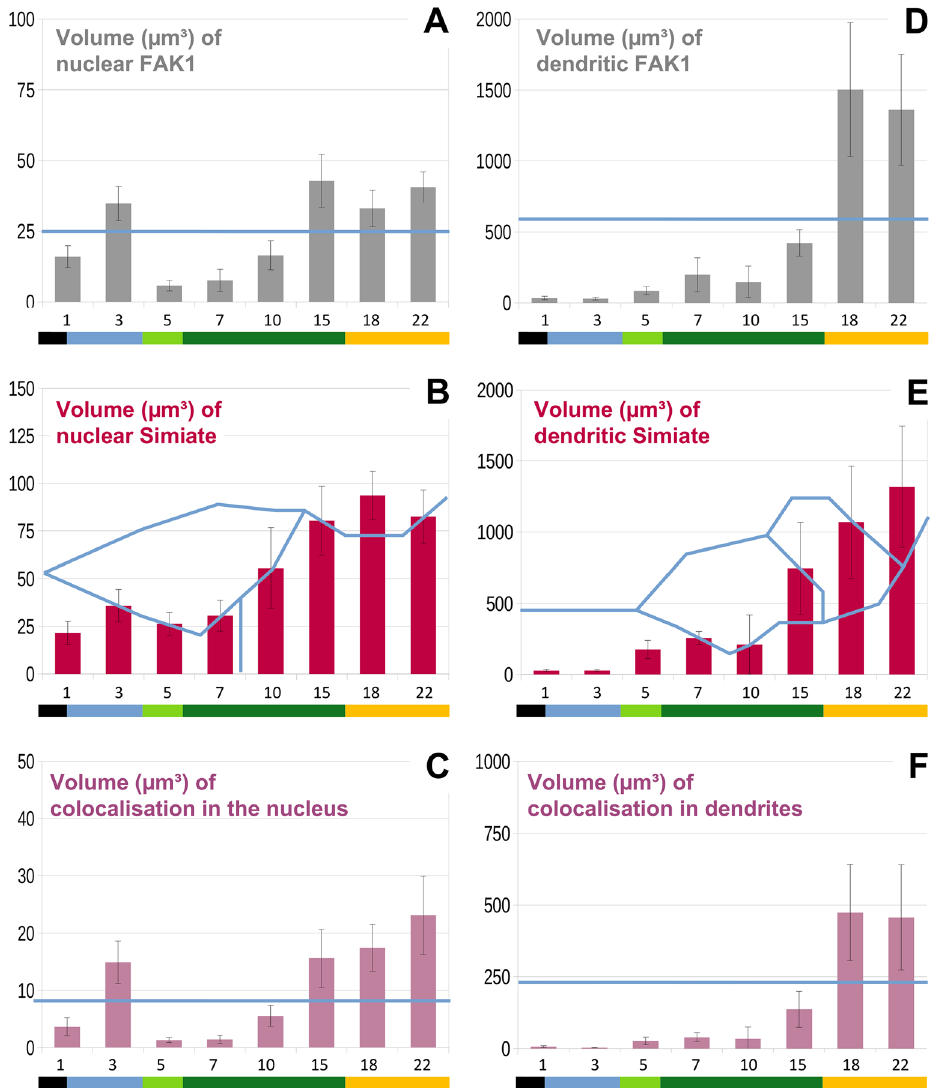
Figure 3. During neuronal development, FAK1 and Simiate display significant variations in their expression levels and their levels of colocalisation in both, nuclei and dendrites. ( A – F ) At several developmental stages between div 1 and div 22, the volumes of FAK1 and Simiate as well as the volumes of proteins colocalised were measured in nuclei ( A – C ) and dendrites ( D – F ) of primary hippocampal neurons by performing 3-dimensional reconstructions. ( A , B ) The graphs illustrate the expression of nuclear FAK1 and Simiate. ( C ) Nuclear Simiate and FAK1 show significant changes in their colocalisation during early neuronal development. ( D , E ) The expression of FAK1 and Simiate in dendrites varies significantly during development. ( F ) In dendrites, the colocalisation of FAK1 and Simiate rises significantly past div 18. In all graphs, blue lines indicate significance borders. Two mean values are significantly different if they are completely separated by at least one blue line, n equals 8–12 in all experiments. Coloured bars indicate the approximate dendritic stage. Black: protrusions indifferent. Blue: axon growth. Green: onset of dendritogenesis and dendritogenesis. Yellow: slowing of dendritogenesis. Please note that for technical reasons, the total volumes of dendritic proteins were calculated based on densities and known dendrite lengths. For further details, please also see Fig.